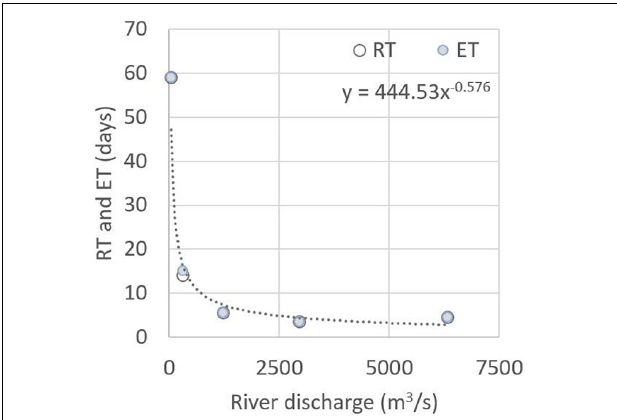
FIGURE 4 | Variation of RT and ET (days) in function of the river discharge (m 3